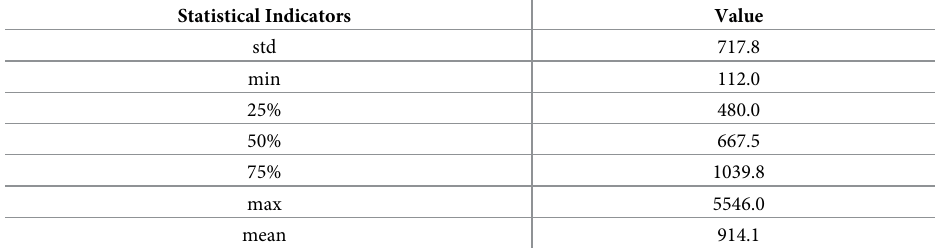
Table 3. A statistical breakdown of the length of news